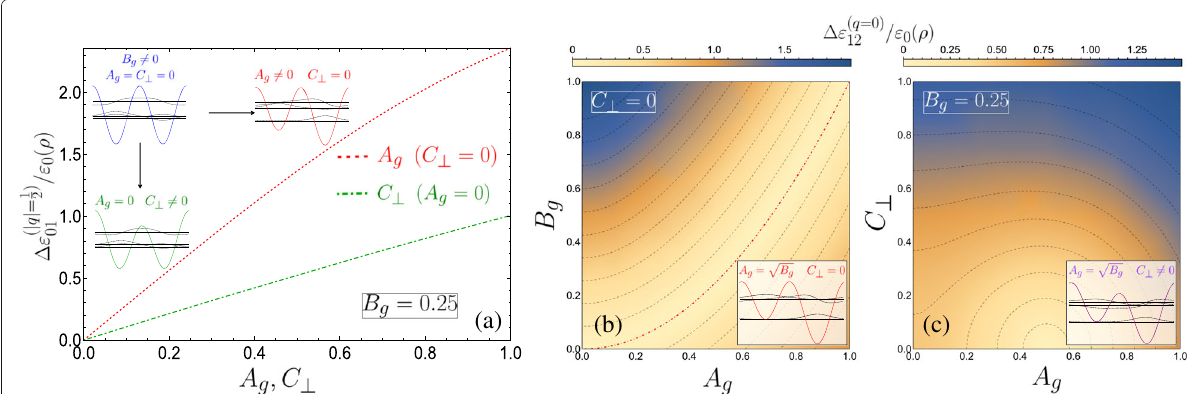
Fig. 4 a Band gap size between ground and first subbands as a function of A g ( C ⊥ ) plotted as dashed red (dot-dashed green), here B g = 0.25. The diagrams indicate the influence of the different perturbations on the isolated DQW unit cell and eigenstates. b – c Band gap size between first and second subbands indicated via a 2D density plot as a function of; b A g and B g for C ⊥ = 0, and c A g and C ⊥ with fixed B g = 0.25. b Adjacent isoenergy (cid:12) B g , while c the difference is 0.13 with zero gap at contour lines indicate a difference of 0.17, with zero gap given by the dot-dashed red line for A g = the centre of the smallest semi-circle contour (0.5,0). The diagrams sketch the isolated DQW and eigenstates. Hybridization does not occur between the s -like and p -like resonant localized individual well states in b , but does in c due to the electric field changing one barrier with respect to the